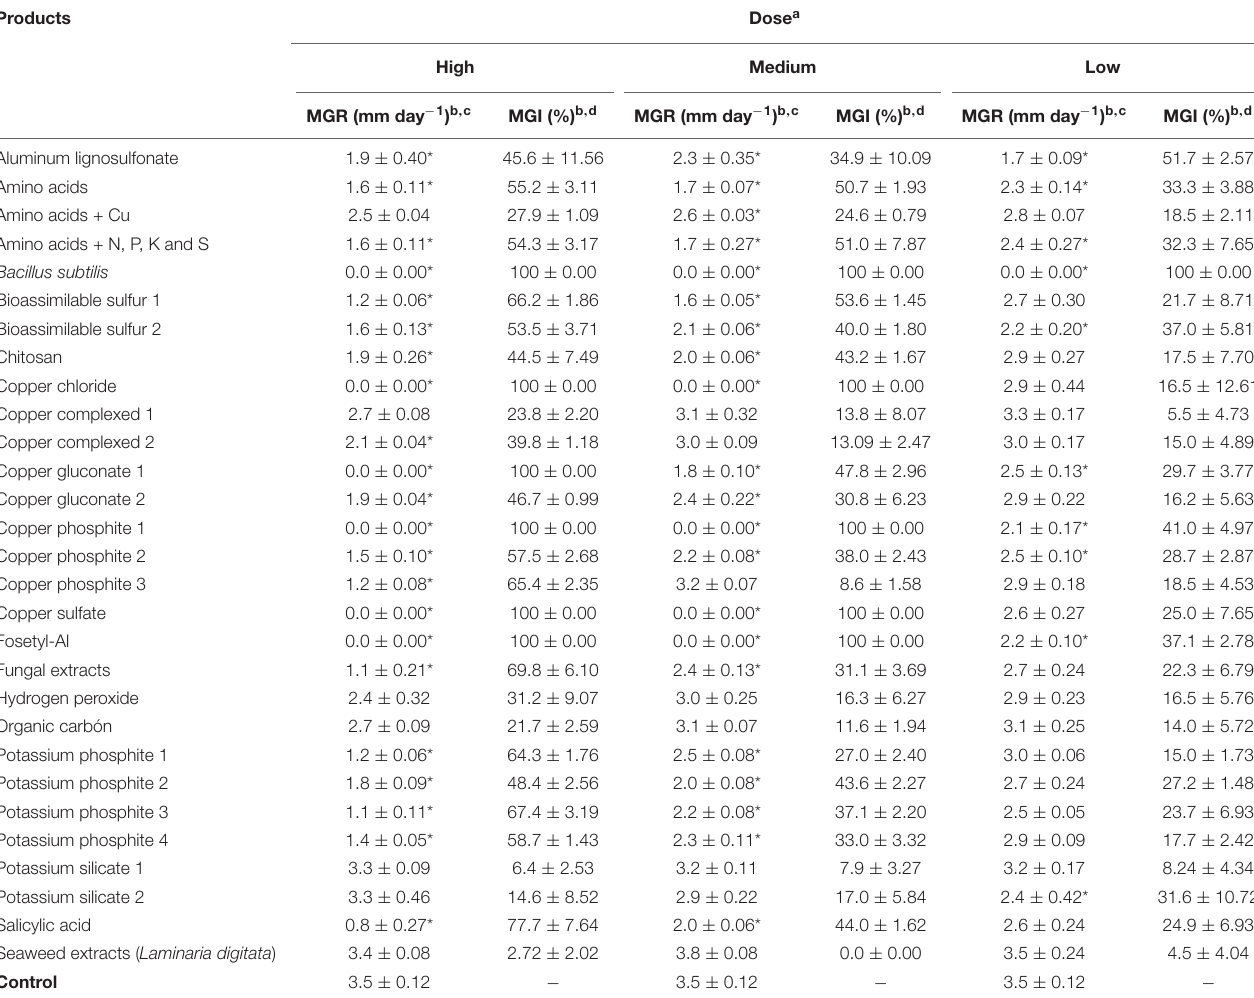
a Dose: high, the maximum dose recommended by the manufacturer of each product for its application by irrigation ( Table 1 ); medium, 1/4 of the high dose; low, 1/16 of the high dose. b Mycelial Growth Rate (MGR; mm day − 1 ) and Mycelial Growth Inhibition (MGI; %) were obtained after growing V. dahliae isolate V180 onto amended or non-amended PDA at 24 ◦ C for 14 days in darkness. In both cases, data represents the average of eight replicated Petri dishes per product and dose combination or control ± the standard error of the means. Only for the MGR variable in the high dose experiment, the square root transformation of the data was performed to satisfy the ANOVA requirements for normality, homogeneity of variances and residual patterns. c For each dose, means of MGR followed by an asterisk (*) differ significantly from the “Control” according to Dunnett’s multiple comparison test at P = 0.05. d For each dose, significant differences between any treatment means of MGI are given by a critical value for means comparison [LSD 0 . 05 = 12.5, 14.0, and 16.8 % for high, medium and low dose, respectively] according to Fisher’s protected LSD test at P =